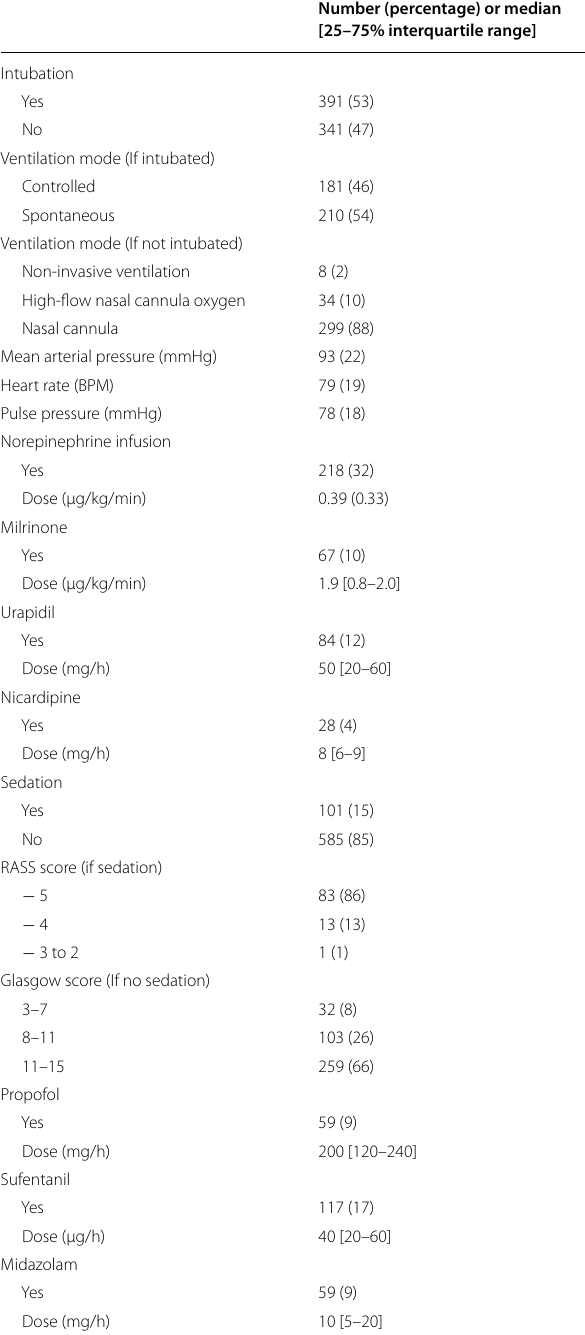
Table 3 Measurement